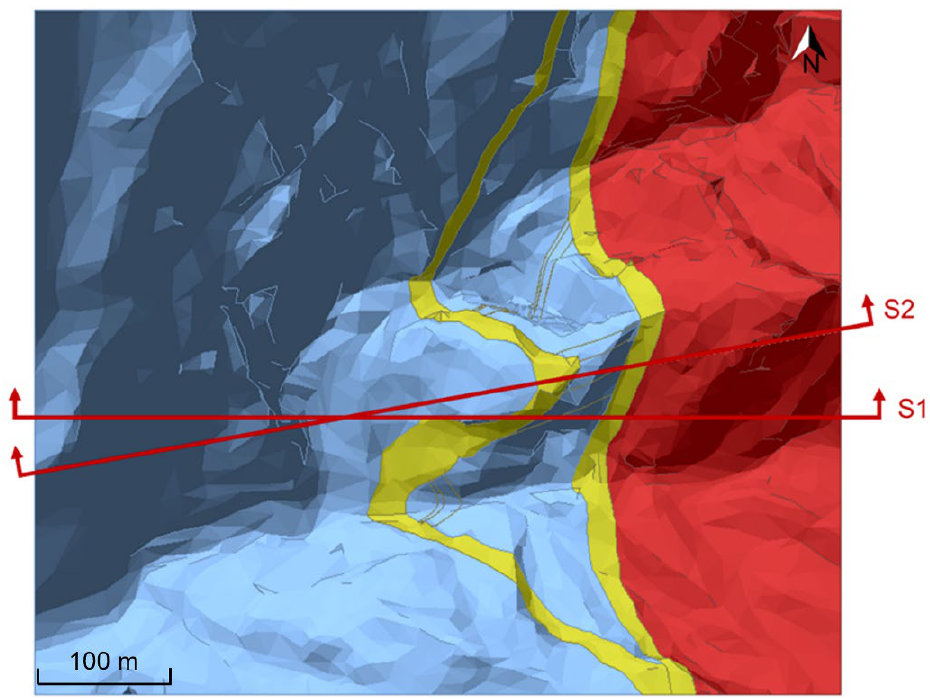
Figure 16. Planimetric view of the 3D geological model. The traces of sections S1 and S2 coinciding and oriented along the CSIRO test sites C1 and C2, respectively, are shown in red. The arrows indicate the look direction of Figures 17, 18, 20, and 21.